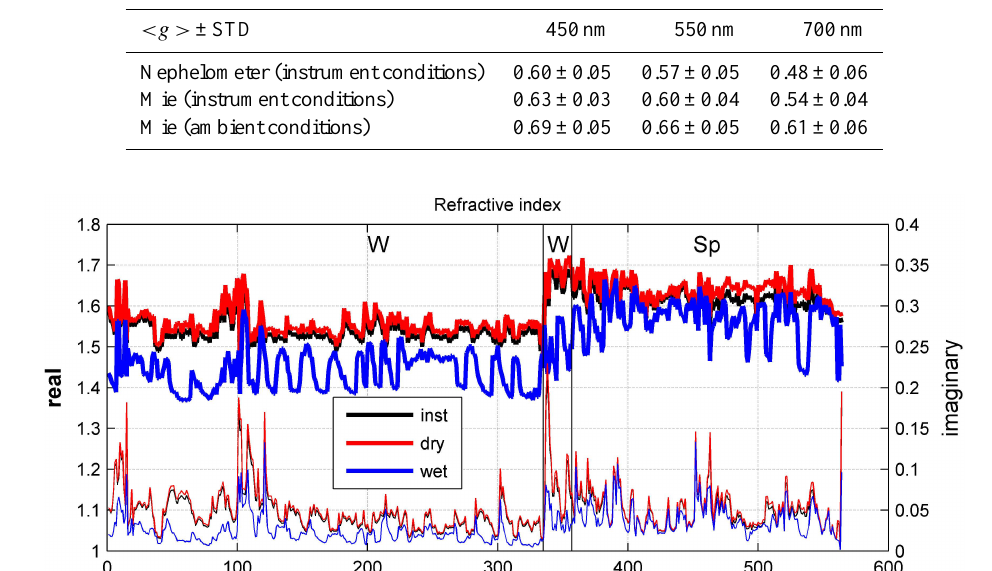
Fig. 5. Refractive index. Thick lines represent the real part (left axis) while thin lines show the imaginary part (right axis). The vertical black lines make the delimitation between different seasons (W = winter, Sp = spring).